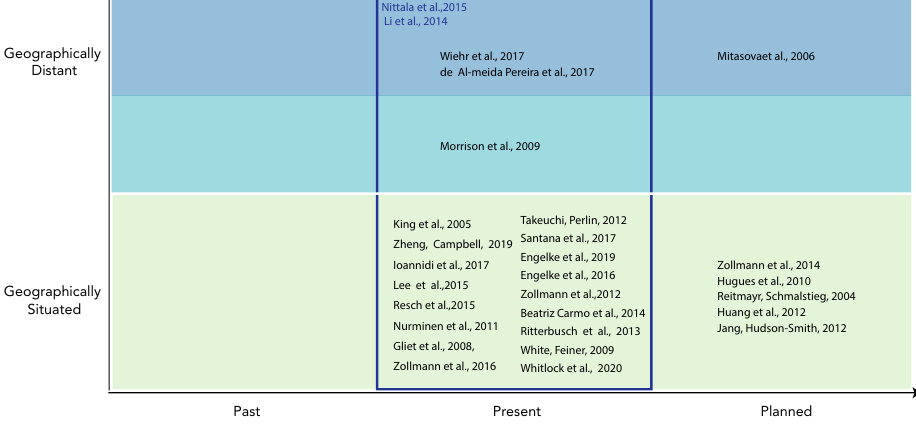
Figure 3. Papers presenting a visualization of abstract data using AR organized by geographical indirection and temporal